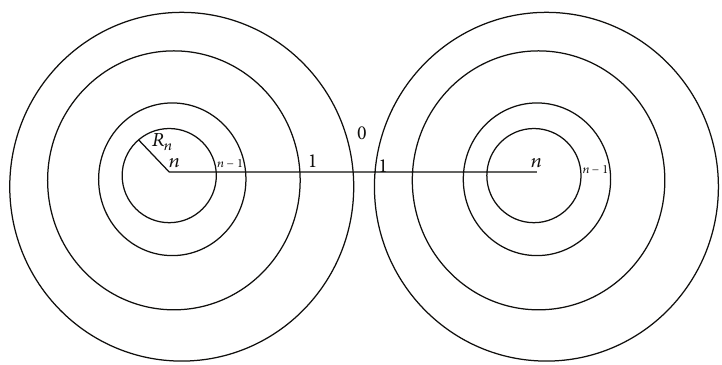
Figure 2: The diagram of two particles with adsorbed layers.